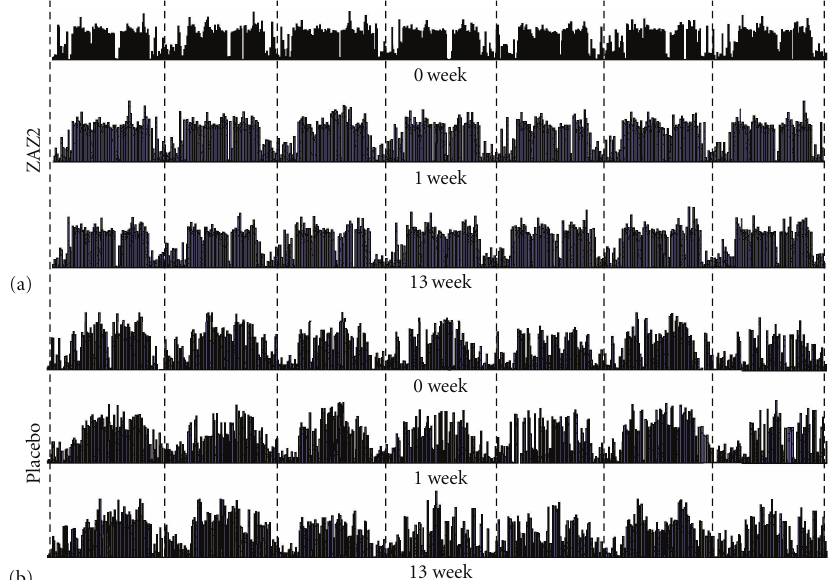
Figure 1: Daily profiles of AMI counts demonstrated the biological rhythm after granule ingestion in the ZAZ2 group (a) and in the placebo group (b). Each dash in the recordings represents